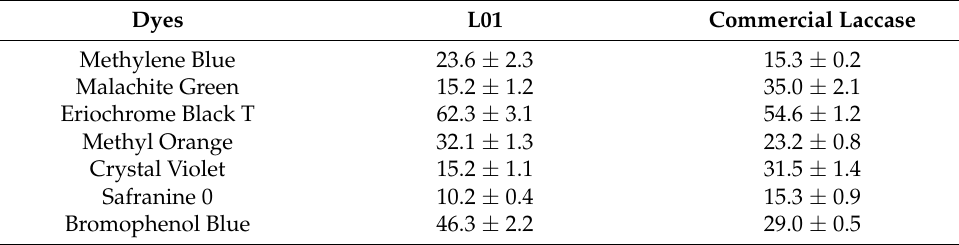
Table 2. Decolorization rates (%) of synthetic dyes by L01 and commercial laccase ( n = 3).